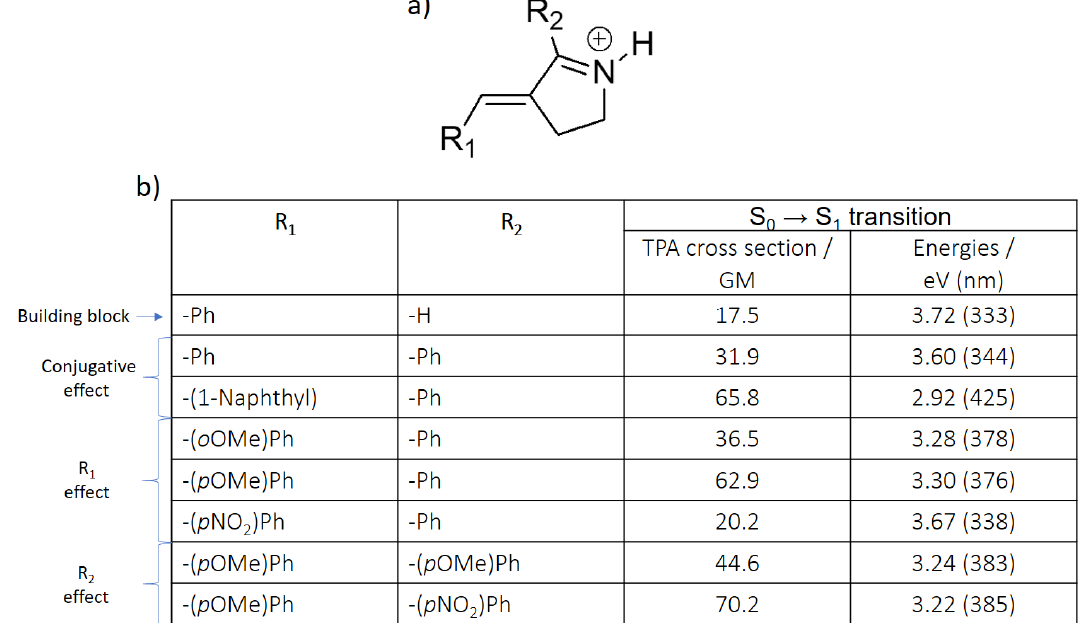
Figure 6. ( a ) Chemical structure of the protonated Schiff base-like derivatives. ( b ) S 0 → S 1 related TPA cross-section and excitation energy values of the E isomer, calculated at the CAM-B3LYP/6-31+G* level of theory.